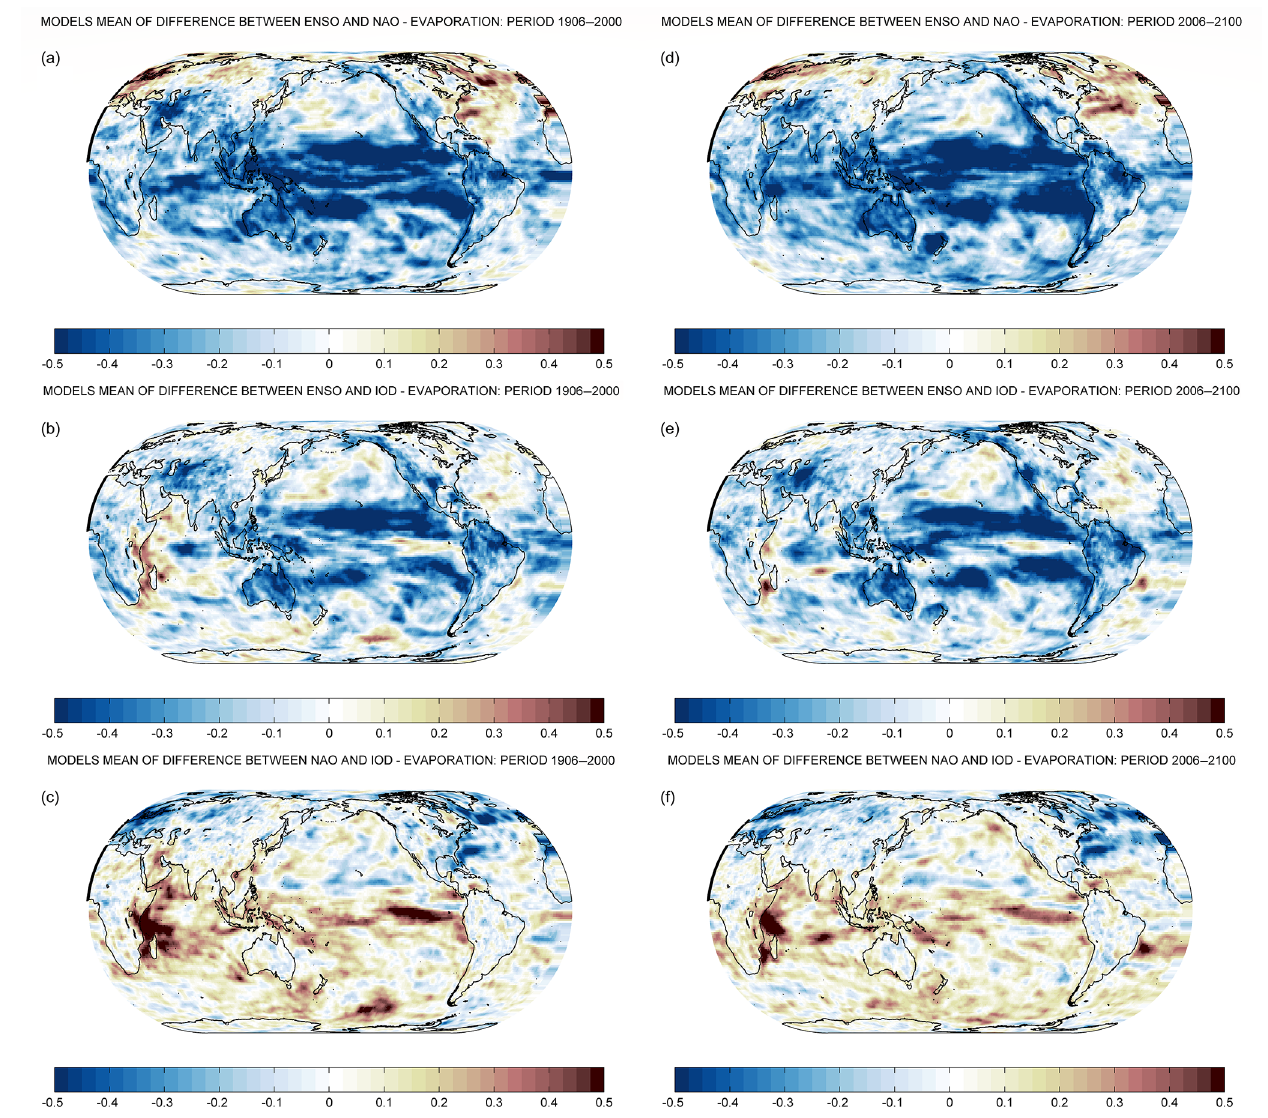
Figure 4. Difference in multi-model mean probability for the absence of Granger causality between a pair of climate modes and annual mean evaporation. The results are shown for the periods 1906–2000 (a, b, c) and 2006–2100 (d, e, f) . ENSO minus NAO (a, d) . ENSO minus the IOD (b, e) . NAO minus the IOD (c, f) . Blue shades indicate a lower probability for the absence of Granger causality. ENSO: El Niño–Southern Oscillation. NAO: North Atlantic Oscillation. IOD: Indian Ocean